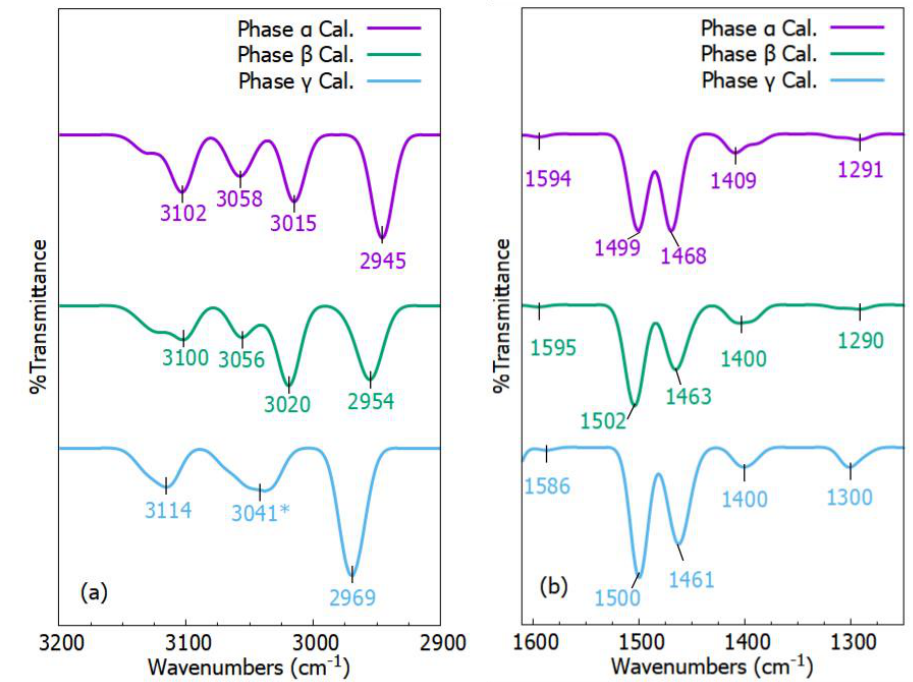
Figure 5. The calculated FT − IR spectra (at atmospheric pressure) of phases α , β , and γ , which are represented by purple, green, and blue colored curves, ranging from ( a ) 3200 cm − 1 to 2900 cm − 1 and ( b ) 1600 cm − 1 to 1250 cm − 1 , respectively . Table 2. Experimental and calculated IR spectra wavenumbers (cm −1 ) with mode assignments, where, υ: stretching, δ: Bending, δ o : out-of- plane bending, δ i : in-plane bending, N/A: not available. Exp.